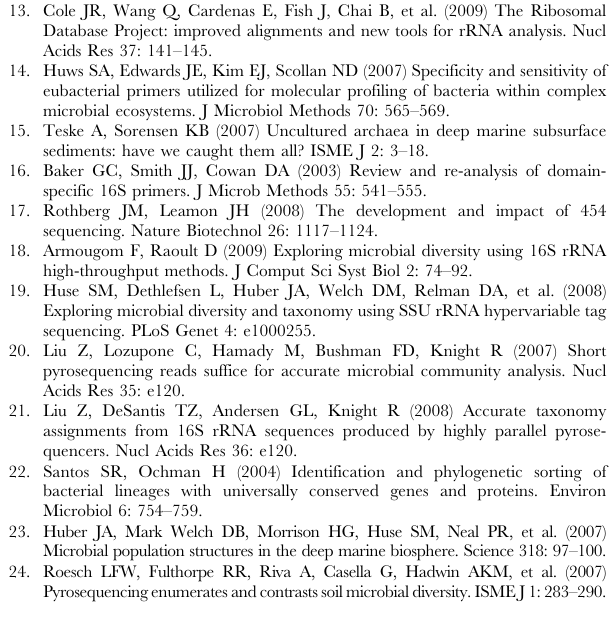
Figure S1 Phyla specification of known primers for archaea.